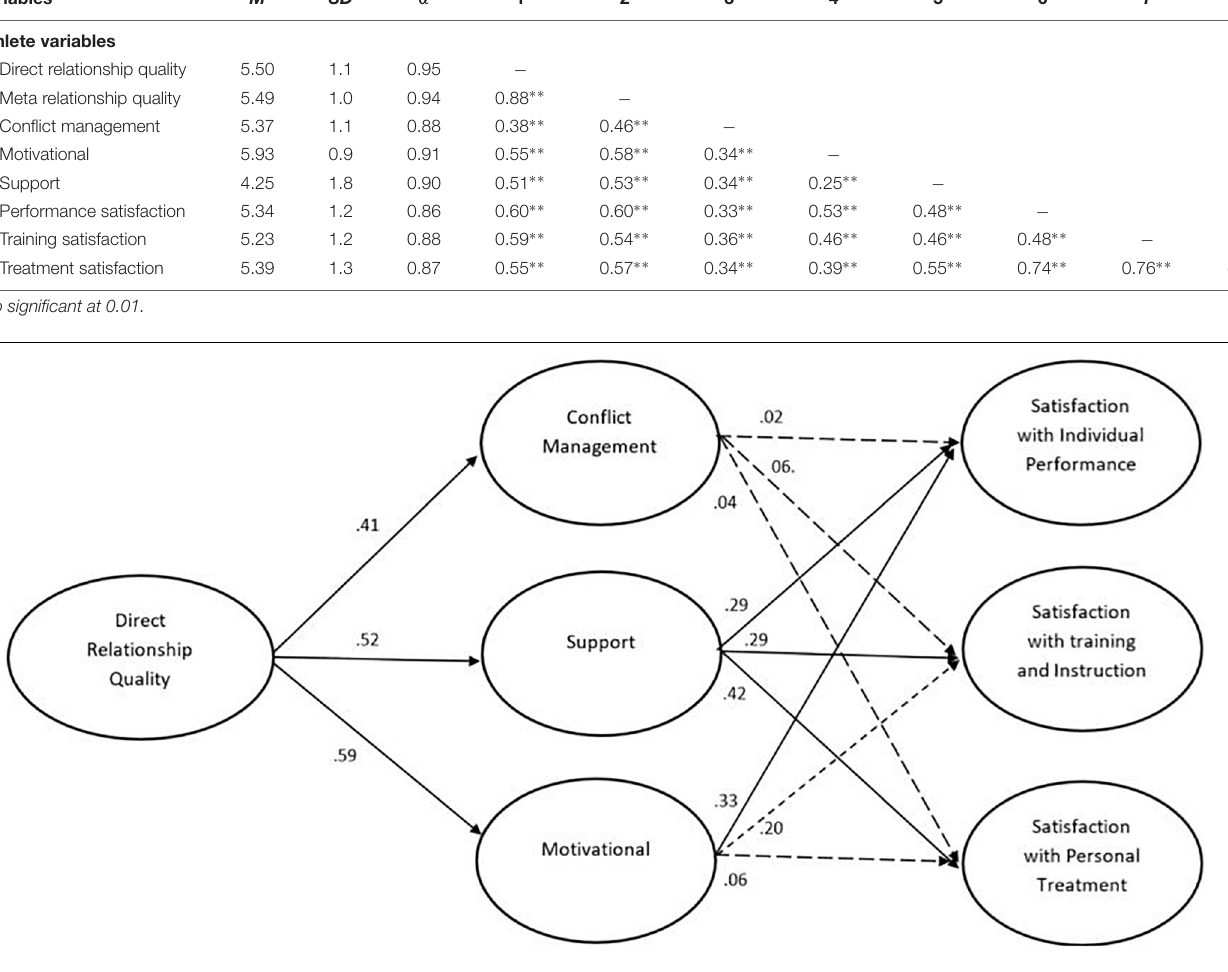
FIGURE 1 | The mediation model describing mediation of relational maintenance strategies in the link between the direct perspective of coach-athlete relationship quality and athlete satisfaction, Only standardized co-efficients are presented, The estimates between relationship quality and sport satisfaction was omitted for